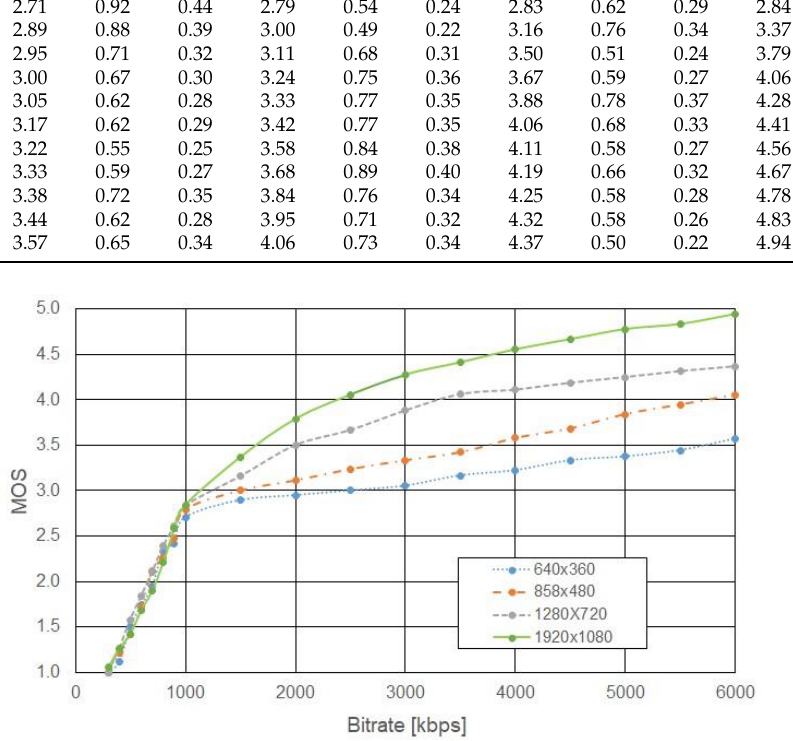
Figure 5. Results of the subjective quality assessment (MOS) for the H.264-encoded video as a function of bit rate for different spatial resolutions—measurements at home [49].